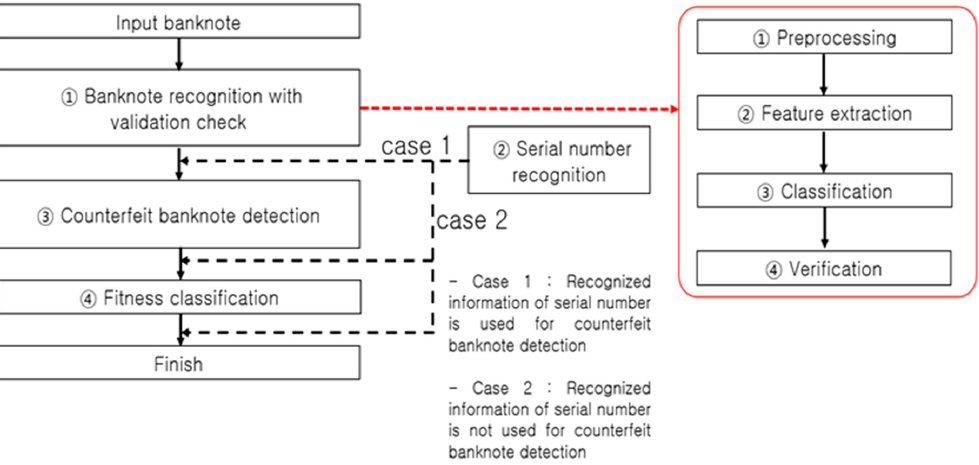
Figure 5. Banknote recognition process flow.